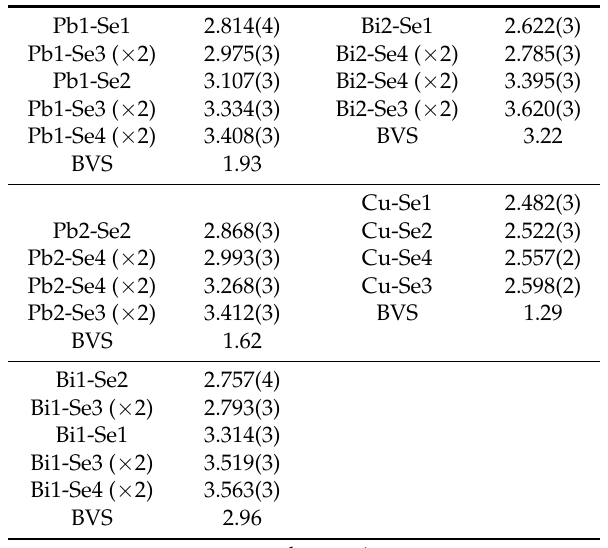
Table 8. Bond distances (in Å) and bond valence sums (BVS in valence units) in the structure of